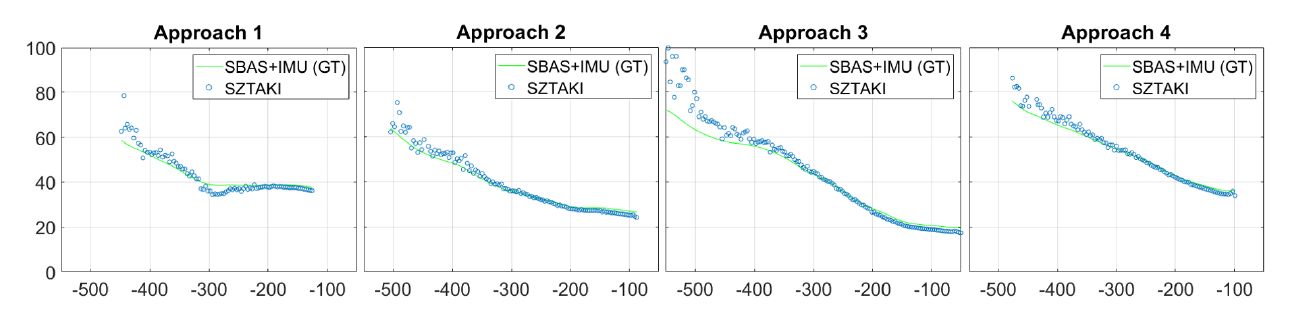
Figure 11. Runway relative altitude ( − Y R [ m ]) measurements of four consecutive runway approaches at